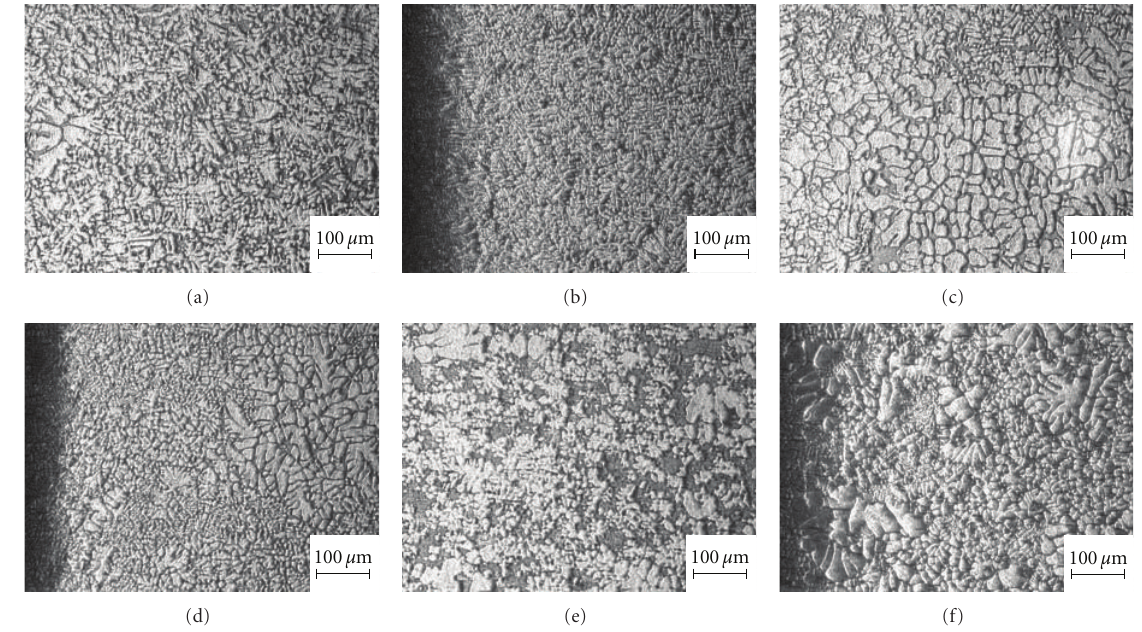
Figure 12: Microstructures of fabricated part by rheo-casting: V L = 0 . 1m/sec, V H = 1 . 0m/sec, Solid fraction: 20%).